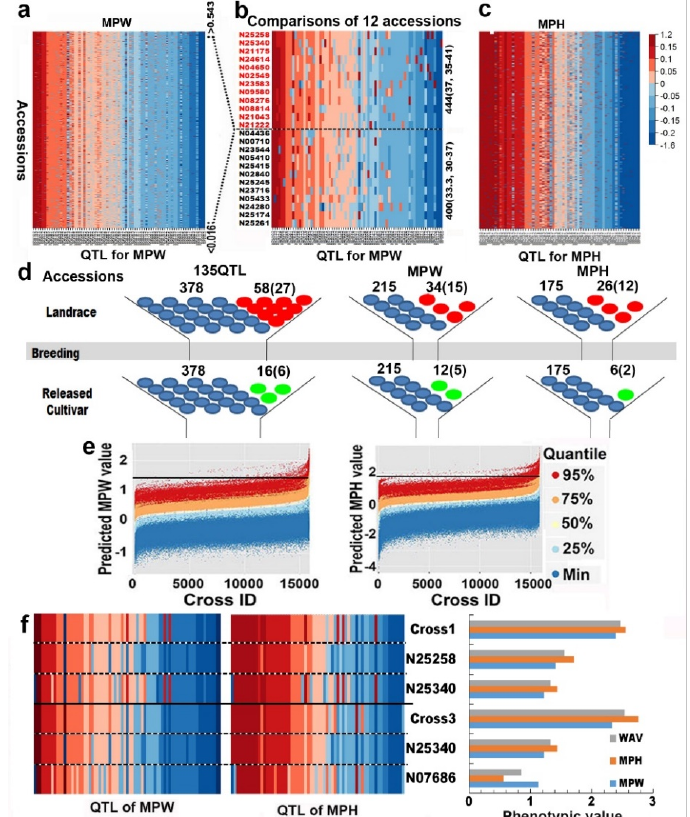
Figure 2. The DT QTL-allele matrices of CCSP and their application in population di ff erentiation, optimal cross design. ( a ) and ( c ), The QTL-allele matrices of MPW and MPH, with the vertical axis for accessions in an increasing tendency from bottom to top, and the horizontal axis for QTL with the number of positive alleles increasing from right to left. The warm color indicates a positive allele and the cool color indicates a negative allele with the depth of color indicating the degrees of allele e ff ect. ( b ) The MPW QTL-allele matrix of the 12 high-DT accessions (red letters) and 12 low-DT checks (black letters). The data at the right side of the matrix is the total number of positive alleles (outside of the parentheses) and the average number of positive alleles followed by a range (in parentheses). The elite accessions have more positive alleles. ( d ) Changes of the genetic diversity from the landrace subpopulation (LRS) to the released cultivar subpopulation (RCS). The colored dots represent di ff erent DT alleles, including the retained alleles in blue color from LRS to RCS, lost alleles in red color during the processes of improvement, and newly emerged alleles in green in RCS. The number in parentheses represents the number of positive alleles. The shaded areas indicate bottleneck e ff ect had happened. ( e ) The distribution of predicted MPW and MPH of progenies from possible crosses. On the horizontal axis, the crosses are arranged according to the predicted means in ascending order from the left to the right. The vertical axis represents the predicted phenotypic values of the predicted progenies. The scattered dots in di ff erent colors represent the di ff erent quantiles of 10,000 progenies. The black horizontal line indicates the maximum value of MPW (1.411), and MPH (1.792) in the CCSP. ( f ) The phenotype value and genetic structure of the two crosses along with their parents. WAV means the weighted average value over the two